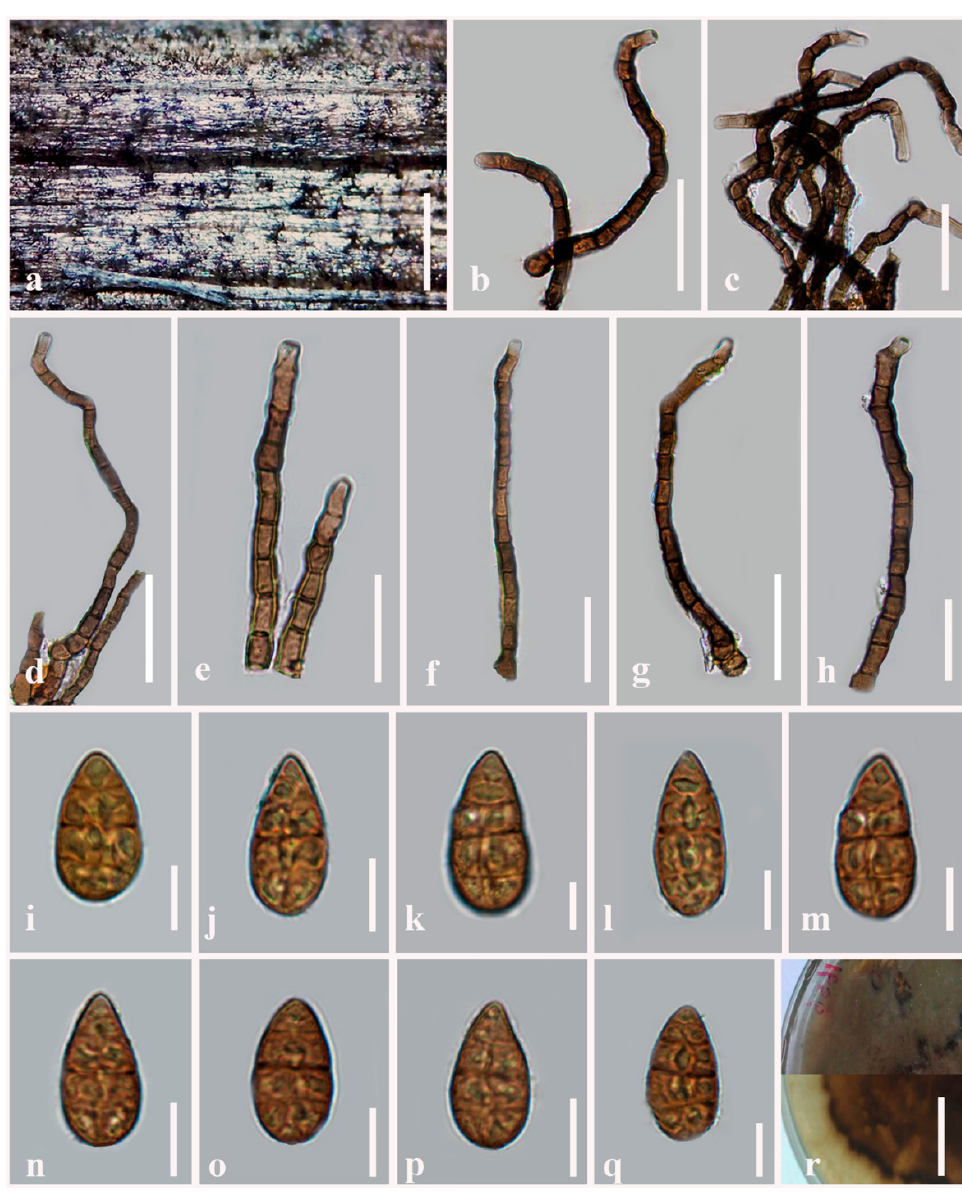
Figure 4. Alternaria ovoidea (MFLU 21-0298, holotype). ( a ) Colonies on dead stem of Dactylis glomerata ; ( b – h ) Conidiophores bearing conidiogenous cells; ( i – q ) Conidia; ( r ) Culture on PDA. Scale bars: ( r ) = 2 cm, ( a ) = 100 µm, ( b – d ,g) = 50 µm, ( e , f , h ) = 30 µm, ( i – q ) = 20 µm.